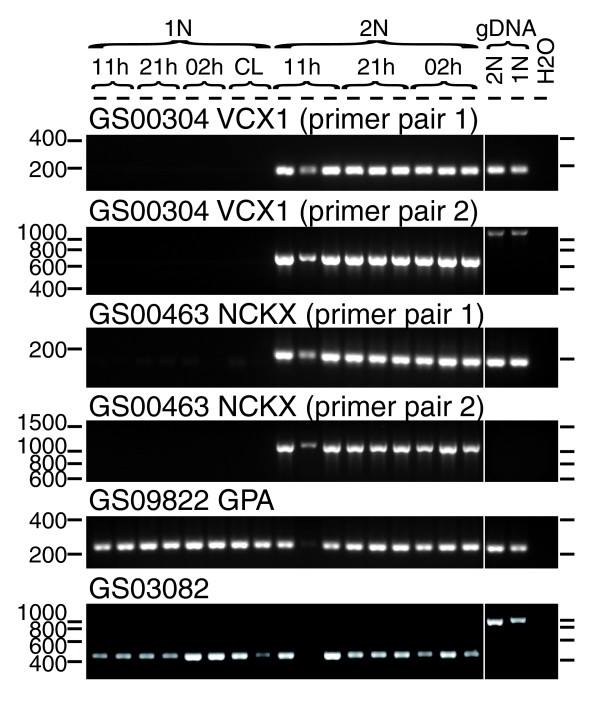
RT-PCR determination of expression patterns of selected genes potentially related to biomineralization. RT- control reactions prepared from the same RNA were run for all of the PCRs shown here and no contaminating genomic DNA (gDNA) was ever found. For clarity, these RT- control reactions run simultaneously have been cut out here. Positions of molecular weight markers on each side of the gel are shown. The sample identifiers are listed for each lane at the top of the gel (as for Figure 7).